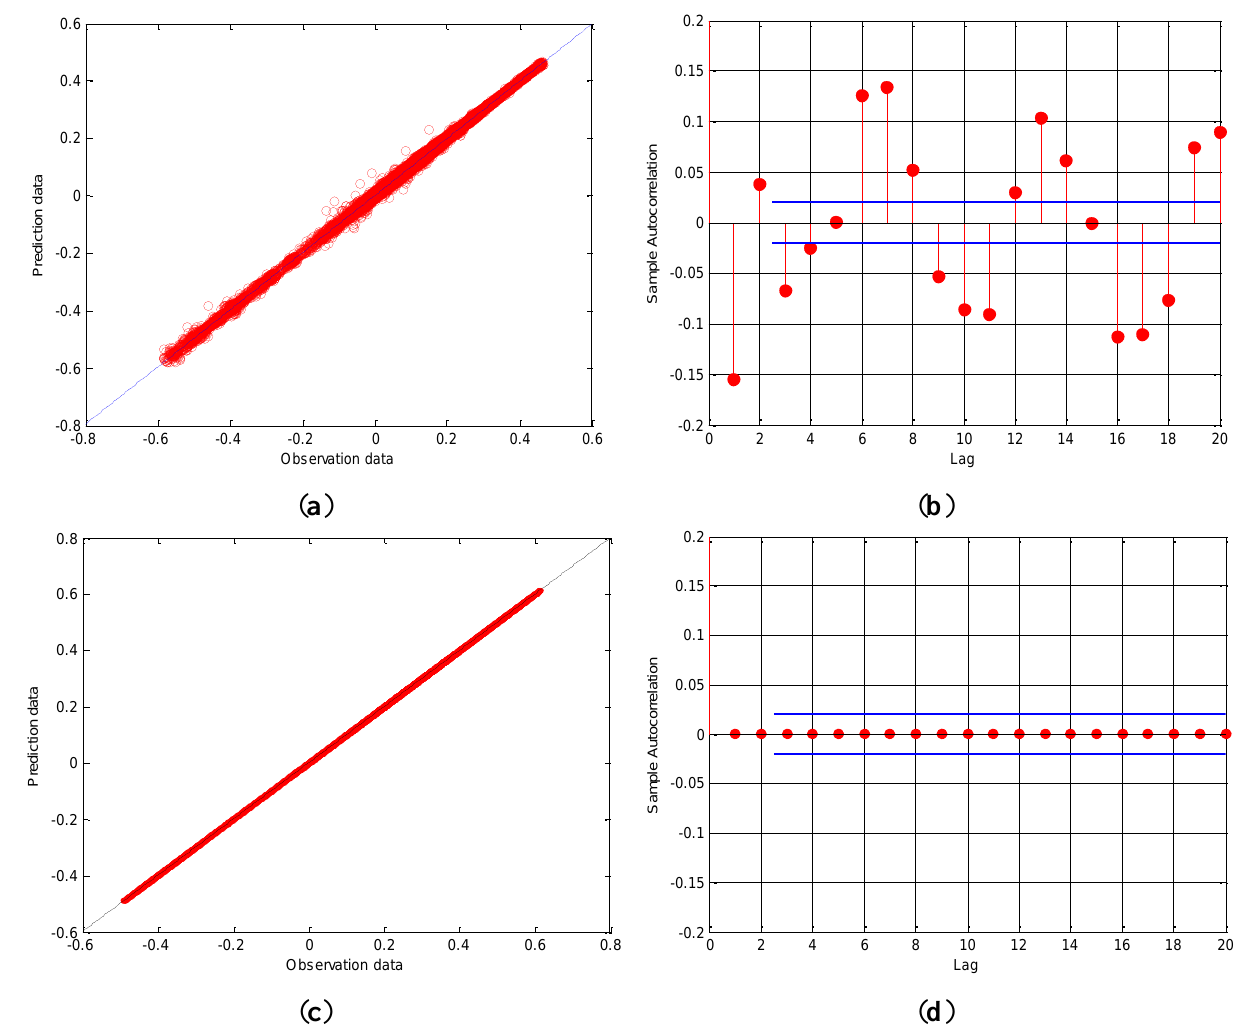
Figure 9. The ANFIS prediction movement for the GPS measurements ( a ) before and ( c ) after wavelet filter applied and ACF for the test monitoring data ( b ) before and ( d ) after filter applied